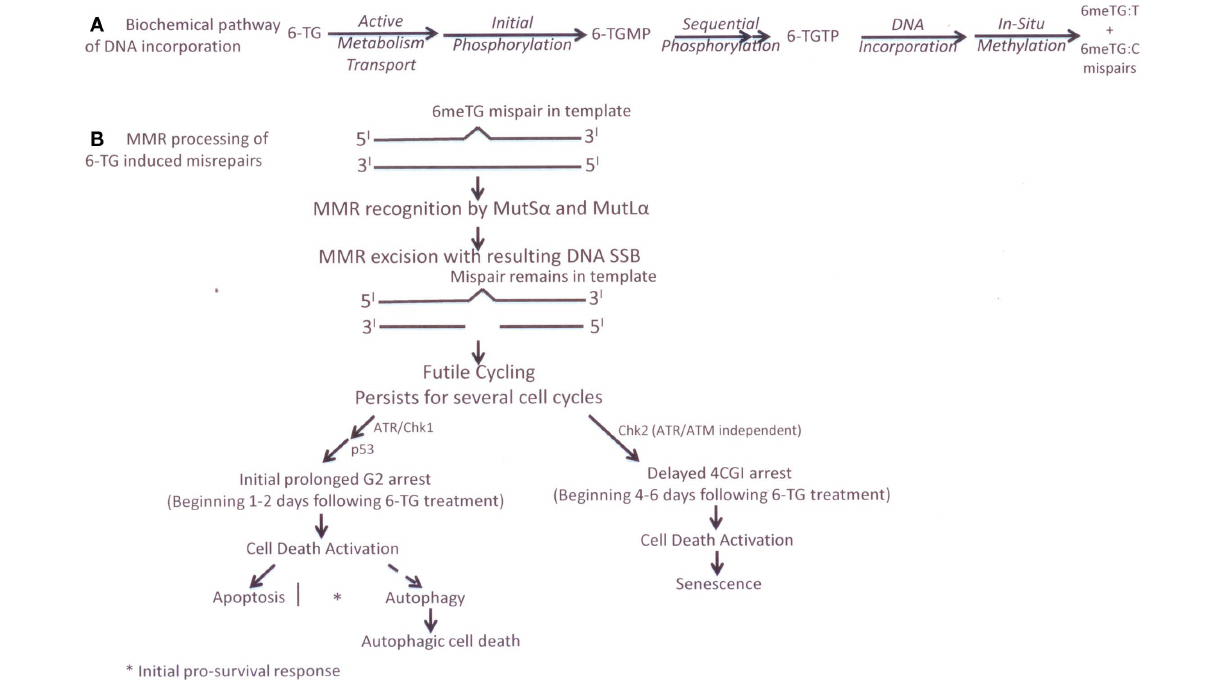
Figure 1 | (A) cellular metabolism of 6-TG (B) current experimental biology futile cycle model of MMR processing of 6-TG-induced DNA base damage in MMR*